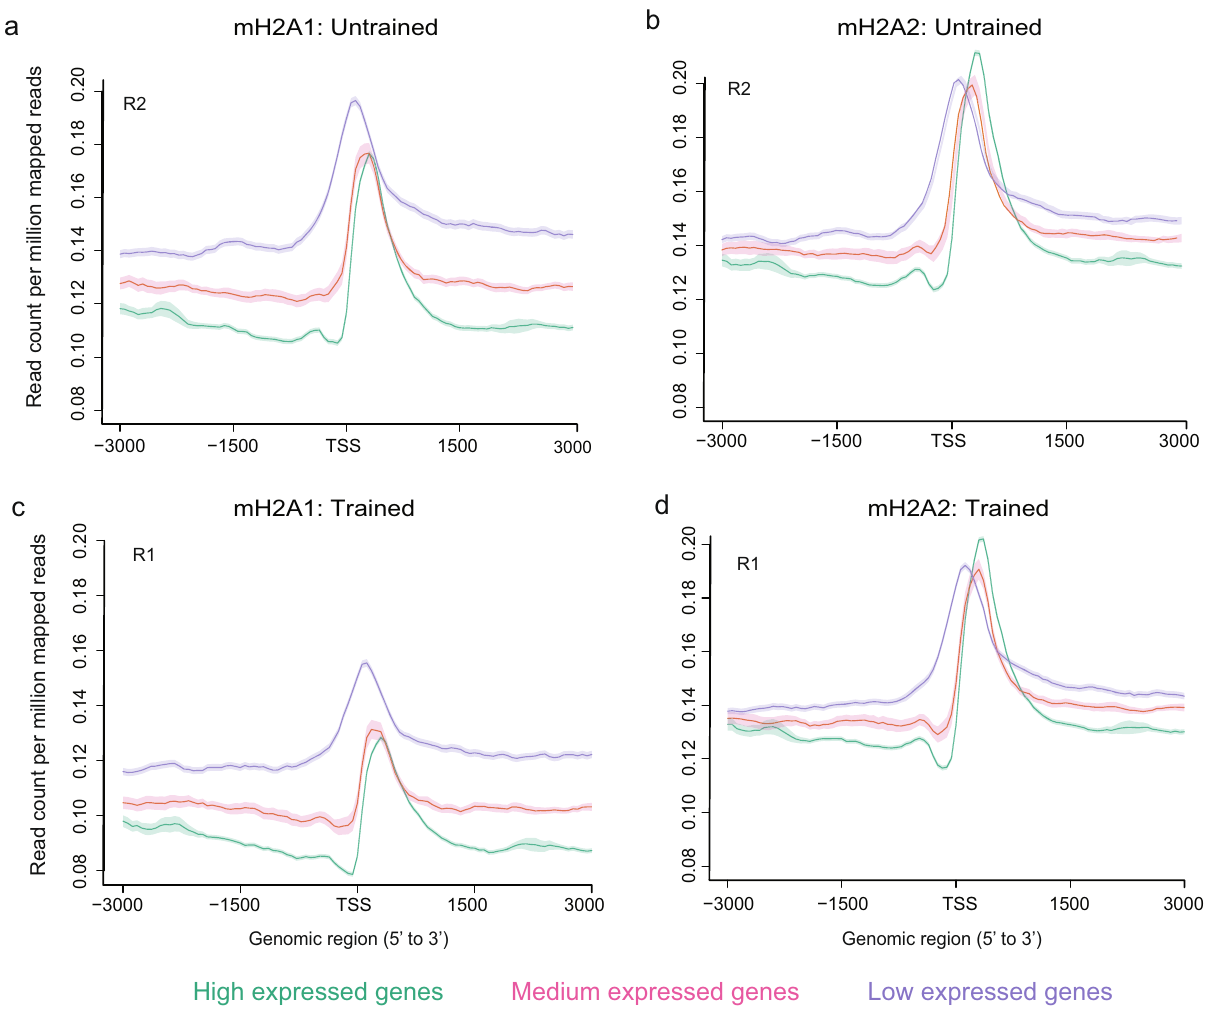
Fig. 4 mH2A1 and mH2A2 binding is negatively associated with gene expression. Average pro fi le plot of mH2A1 binding at the TSS for all genes grouped into three categories of gene expression (high, medium and low) shows that mH2A1 ( a ) and mH2A2 ( b ) enrichment is inversely proportional to gene expression in untrained ( c ) and trained ( d ) mice. Data for each mH2A protein are shown for individual replicates from untrained (replicate 2; R2) and trained (replicate 1; R1)